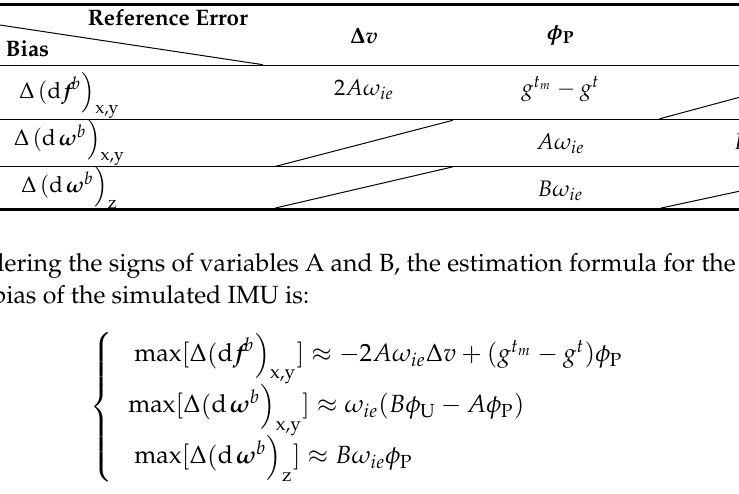
Table 1. Maximum Propagation Coefficient of Simulated IMU